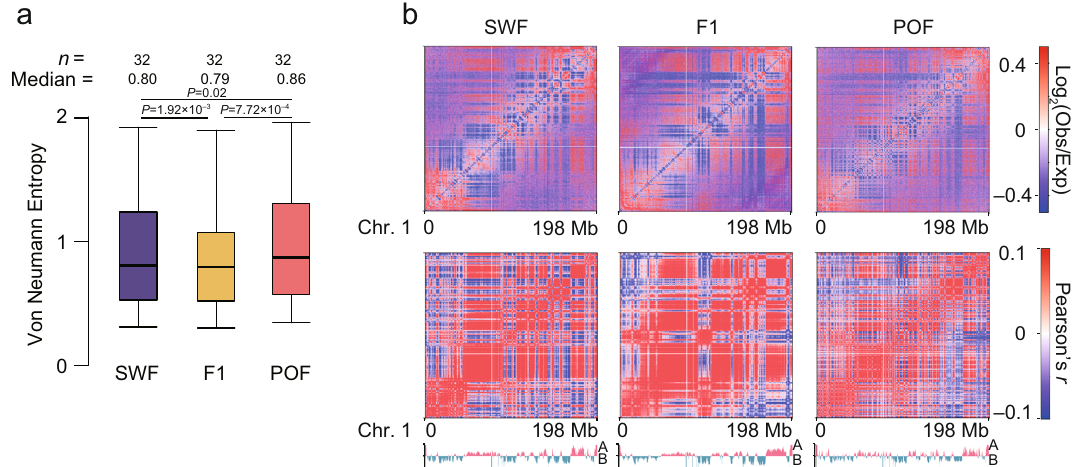
Fig. 2 Dynamic changes of chromatin architecture during granulosa cell development. a Quanti fi cation of the disorder in the chromatin structure of the whole genome using Von Neumann Entropy (VNE). P values were calculated using two-sided Wilcoxon rank-sum test. In the boxplot, the internal line indicates the median, the box limits indicate the upper and lower quartiles and the whiskers extend to 1.5 IQR from the quartiles. b Normalized Observed/ Expected contact maps (top panels) and correlation matrixes of PC1 values (bottom panels) at 20 kb resolution for chromosome 1. Source data are provided as a Source Data fi